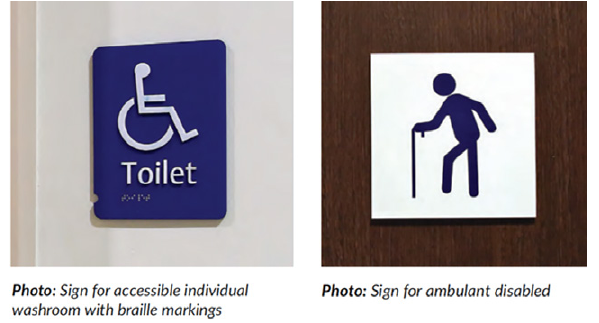
Figure 9. Logos mentioned in “Universal Design Guide for Public Places” (BCA,